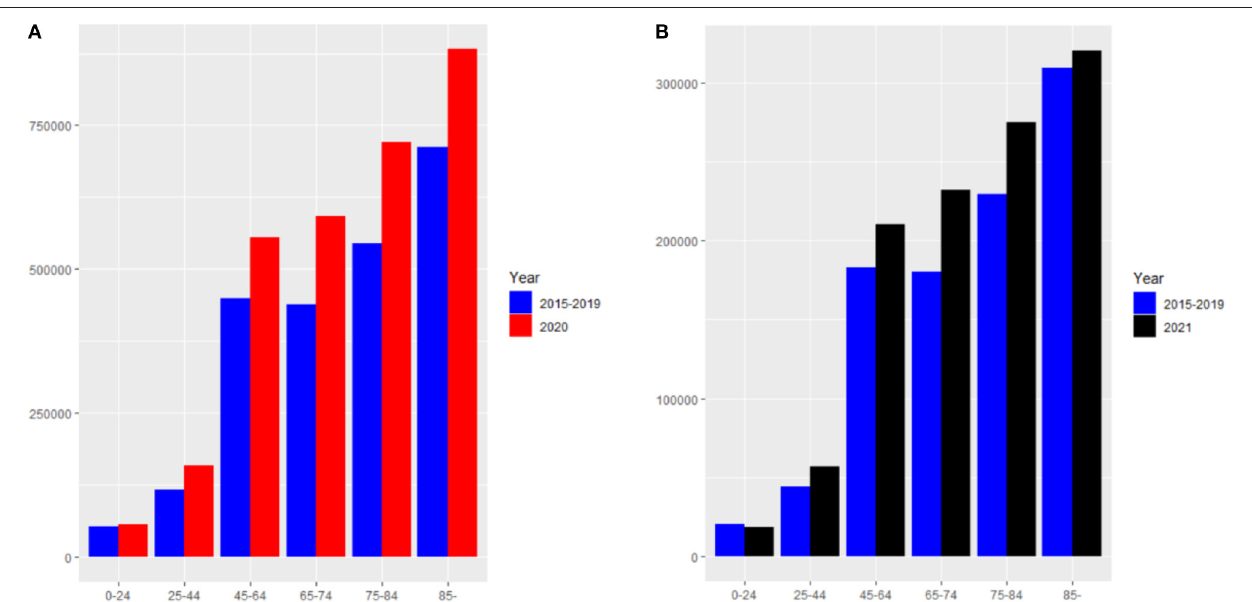
FIGURE 2 | (A) The death numbers from the 9 th week to the 52 nd week in 2020 and the average death numbers in the same period from 2015 to 2019. (B) The death numbers from the 1 st week to the 17 th week in 2021 and the average death numbers in the same period from 2015 to 2019.